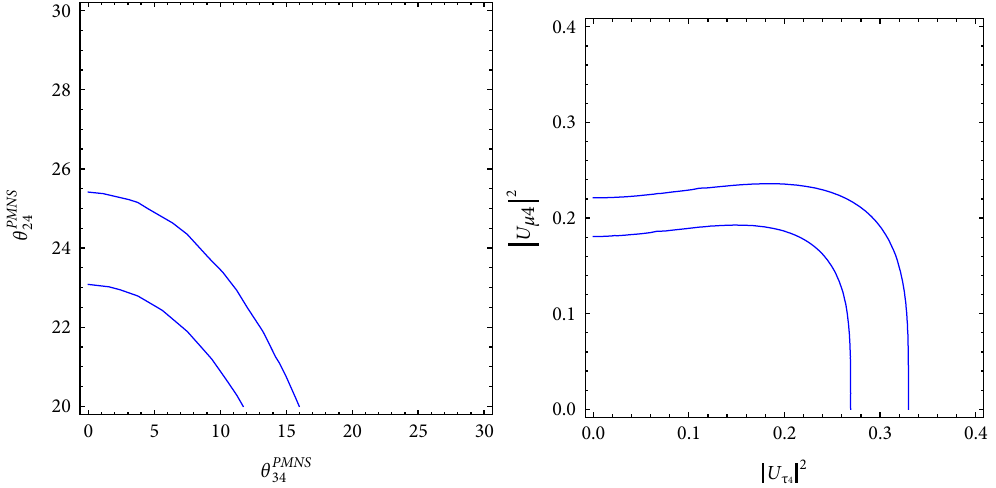
for 𝑚 = 400𝐺𝑒𝑉 (left) and 𝑚 𝑡 󸀠 34